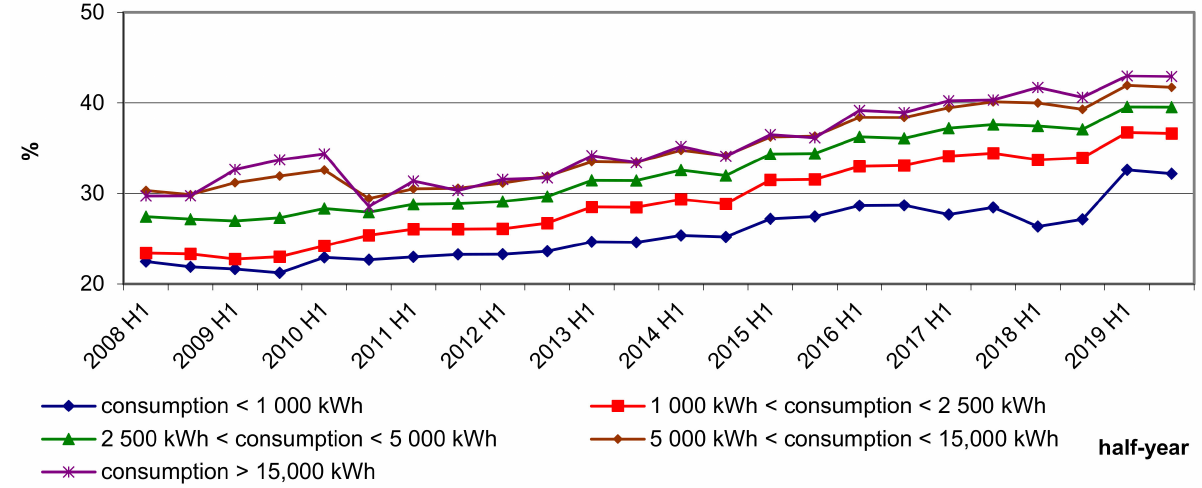
Figure 3. The contribution of levies and taxes in electricity prices for private customers in European Union in